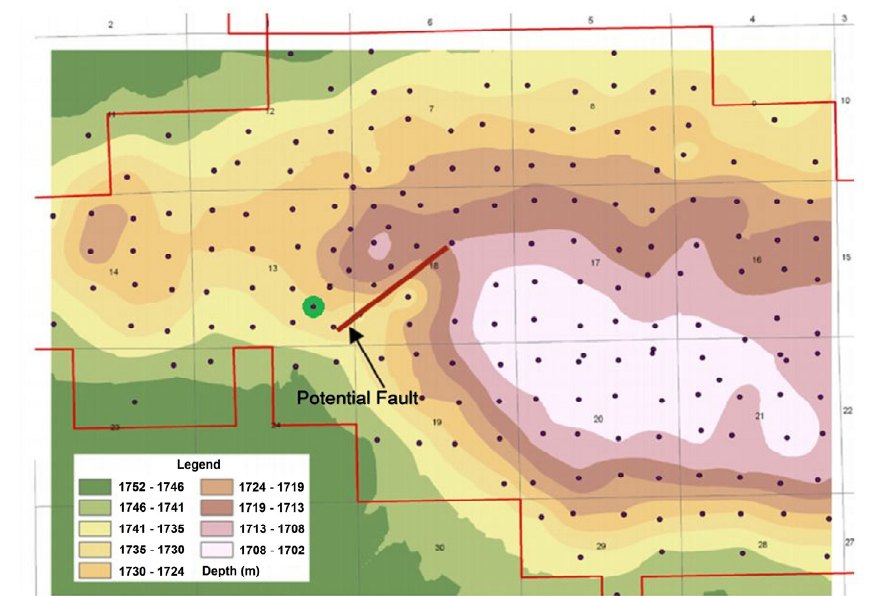
Figure 2. Depth of the top of the Desert Creek reservoir [12].